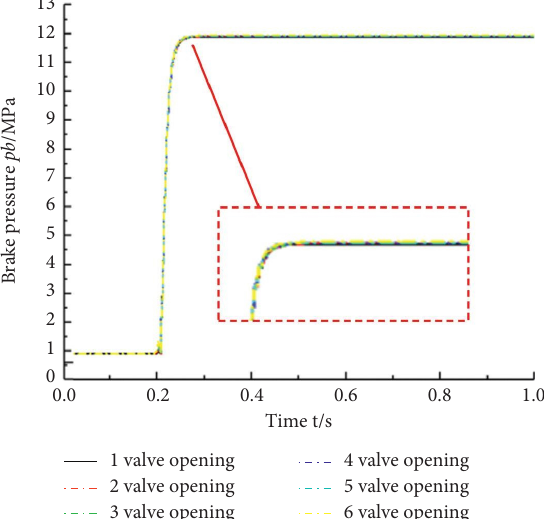
Figure 15: Pressure output of two-stage brake pressure servo valve with multiple valves in parallel at 21MPa oil supply.